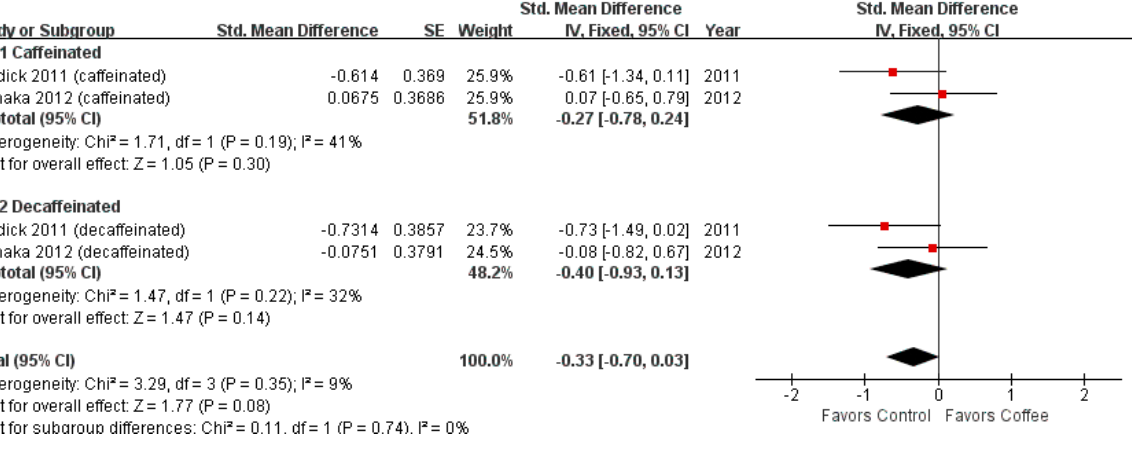
Figure 5. Effects of coffee on Matsuda index.